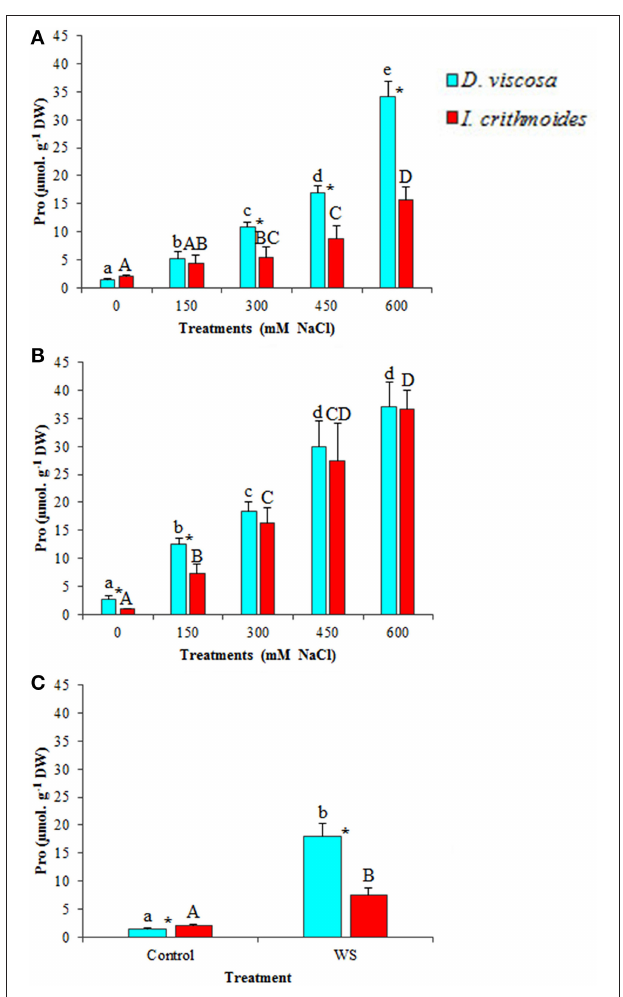
FIGURE 5 | Proline (Pro) accumulation in leaves of D. viscosa and I. crithmoides stressed plants. Pro contents after 3 weeks (A) and 6 weeks (B) of treatment with the indicated NaCl concentrations, or after 3 weeks of water stress (C) . Values shown are means ± SD ( n = 5 ). Different letters (lowercase for D. viscosa and capital letters for I. crithmoides ) over the bars indicate significant differences between treatments for each species according to Tukey test ( α = 0.05). Asterisks ( * ) indicate significant differences between the two species for the same